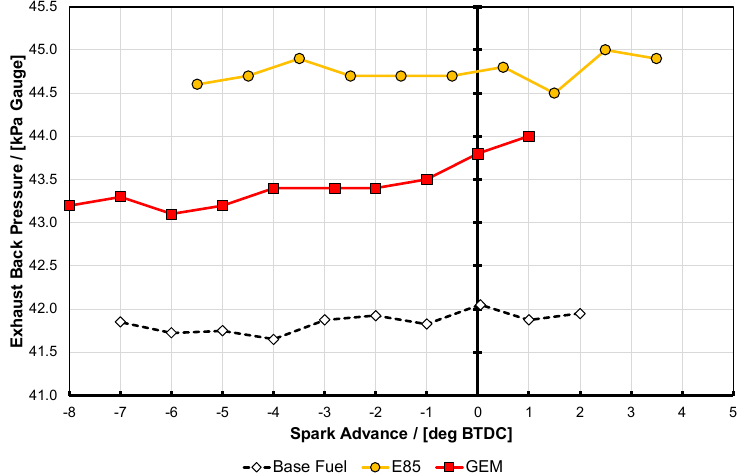
Figure 6. Exhaust back pressure for the data presented in Figure 4, taken at test point A. See text for discussion on accuracy of the results.